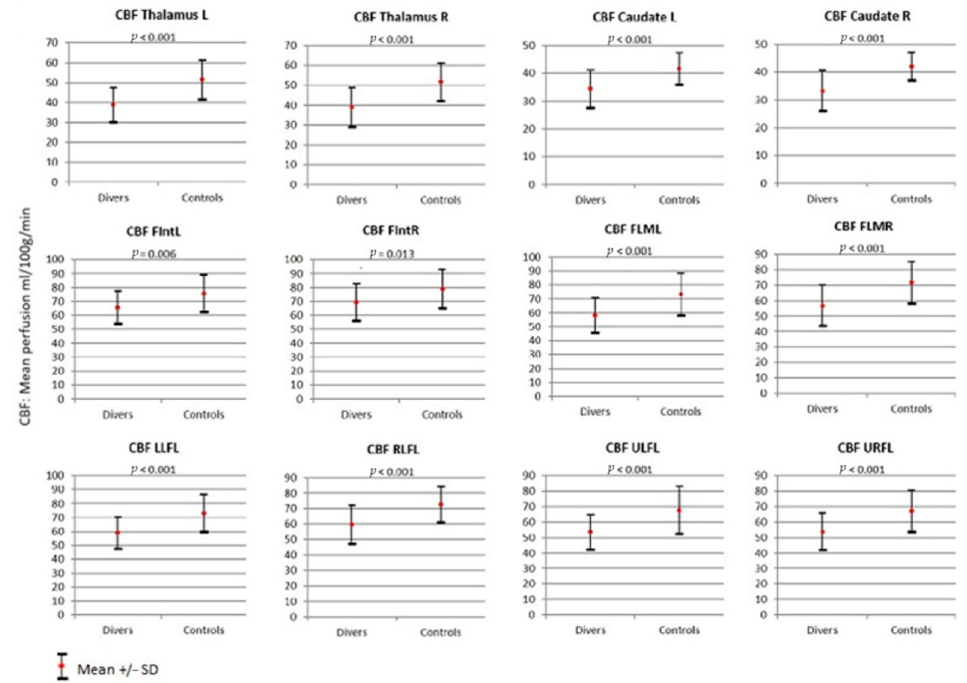
Figure 4. Determination of cortical cerebral blood flow measured through the 3D-pASL sequence. Comparison of findings in the divers group versus control group. Abbreviations: CBF: cerebral blood flow; L: left; R: right; FIntL: frontal internal left; FIntR: frontal internal right; FLML: frontal lobe, middle left; FLMR: frontal lobe, middle right; LLFL: left lower frontal lobe; RLFL: right lower frontal lobe; ULFL: upper left frontal lobe; URFL: upper right frontal lobe.